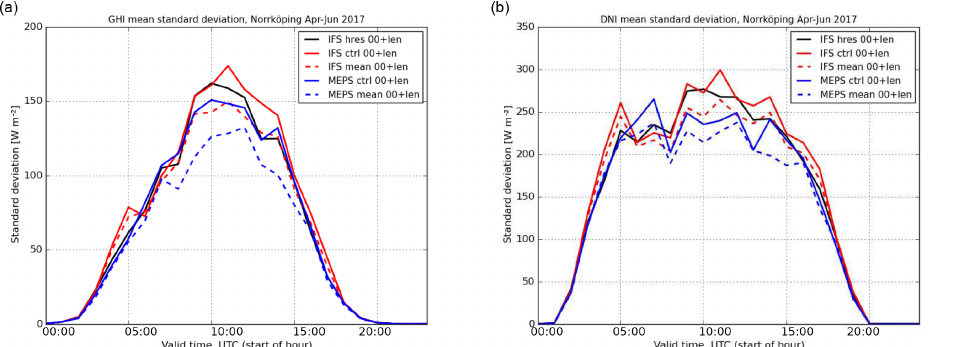
Figure 2. Standard deviation of differences between modelled and measured GHI (left) and DNI (right), Norrköping, April–June 2017.